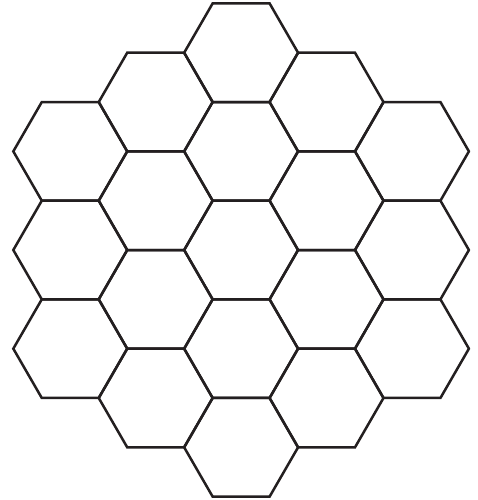
Figure 4: Honeycomb network. n